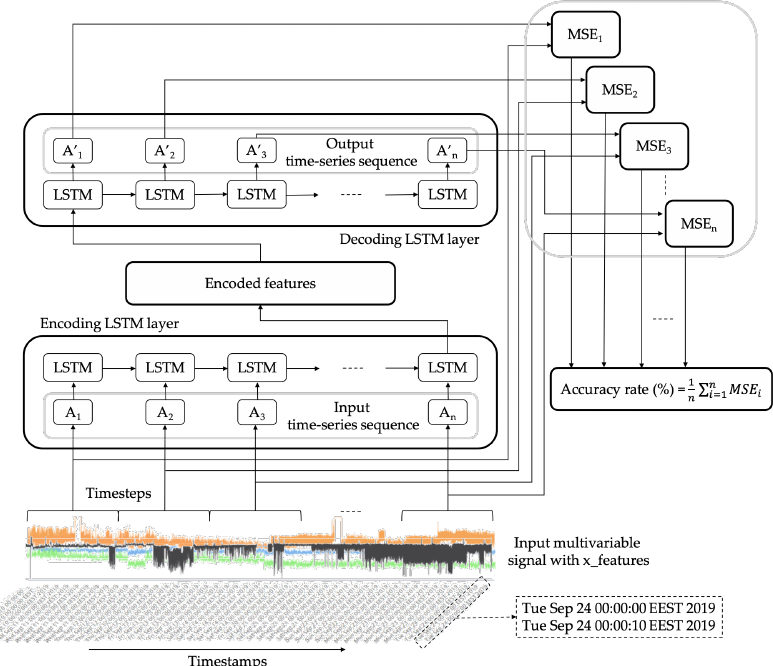
Figure 1. High-level Long Short-Term Memory (LSTM)-autoencoder